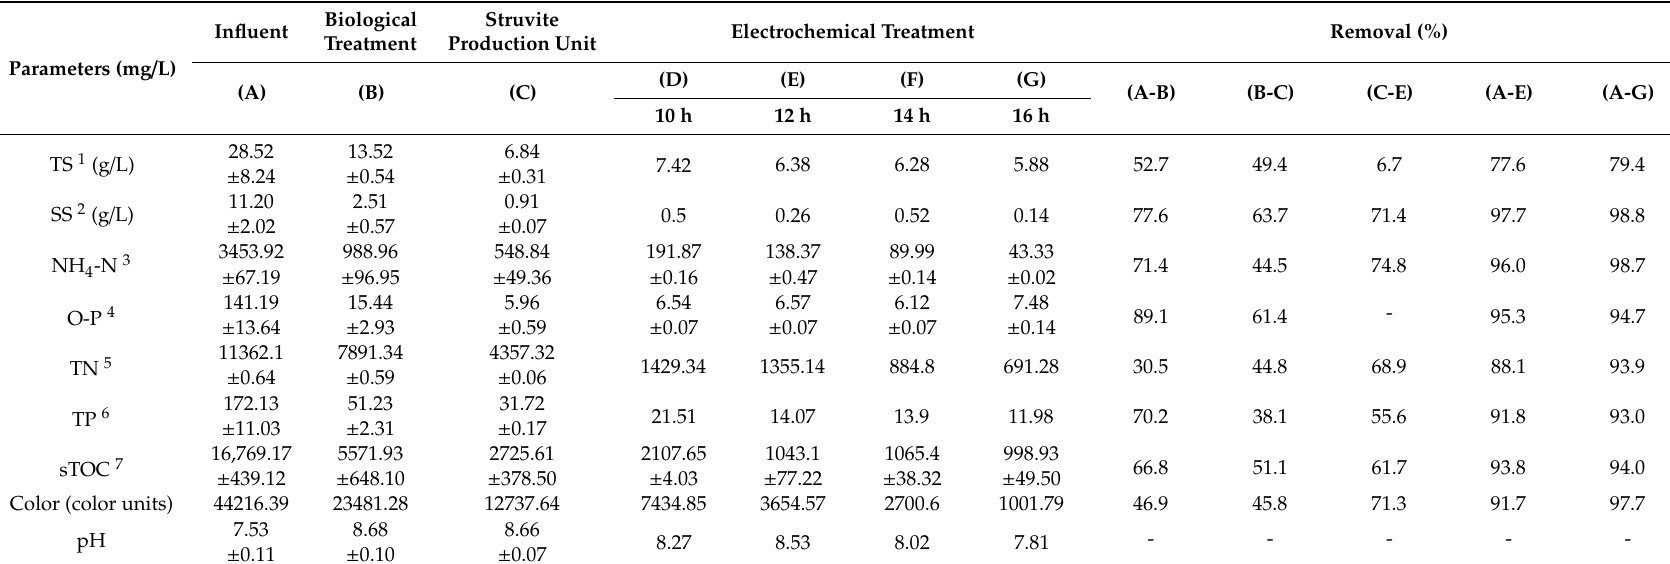
Table 2. Characteristics of e ffl uent according to unit processes in the